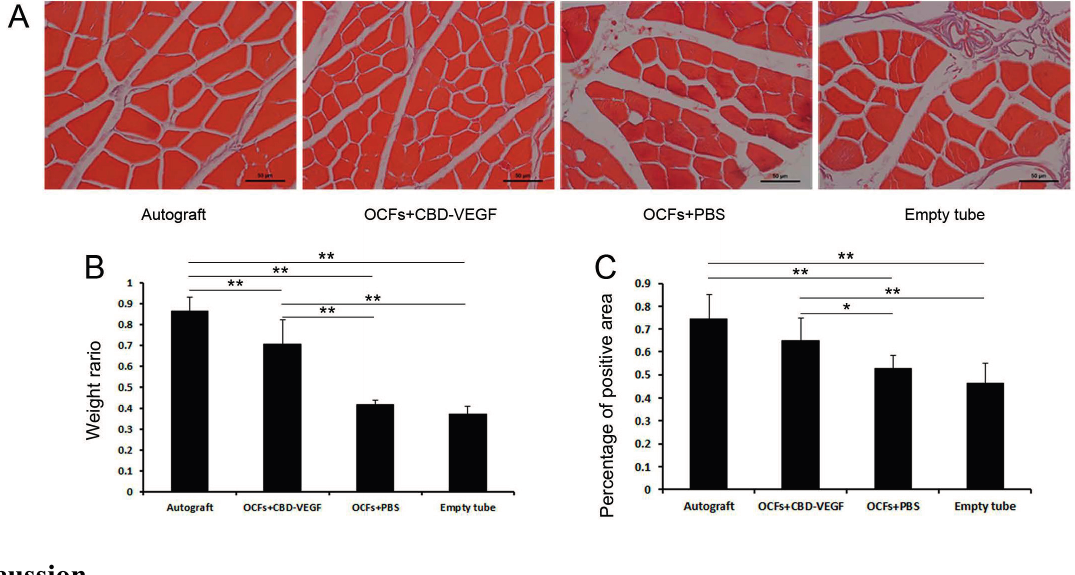
Figure 8. Measurement of gastrocnemius muscle at 12 weeks after surgery. ( A ) Light micrographs of gastrocnemius muscles following Masson’s trichrome staining in each group. Scale bar, 50 µm; ( B ) The wet weight ratios of gastrocnemius muscle (injured side/uninjured side) for the three grafted groups; ( C ) Statistical analysis of the percentage of muscle-positive area in transverse sections from each group. Data are expressed as mean ± SD, n = 4, * p < 0.05, ** p <